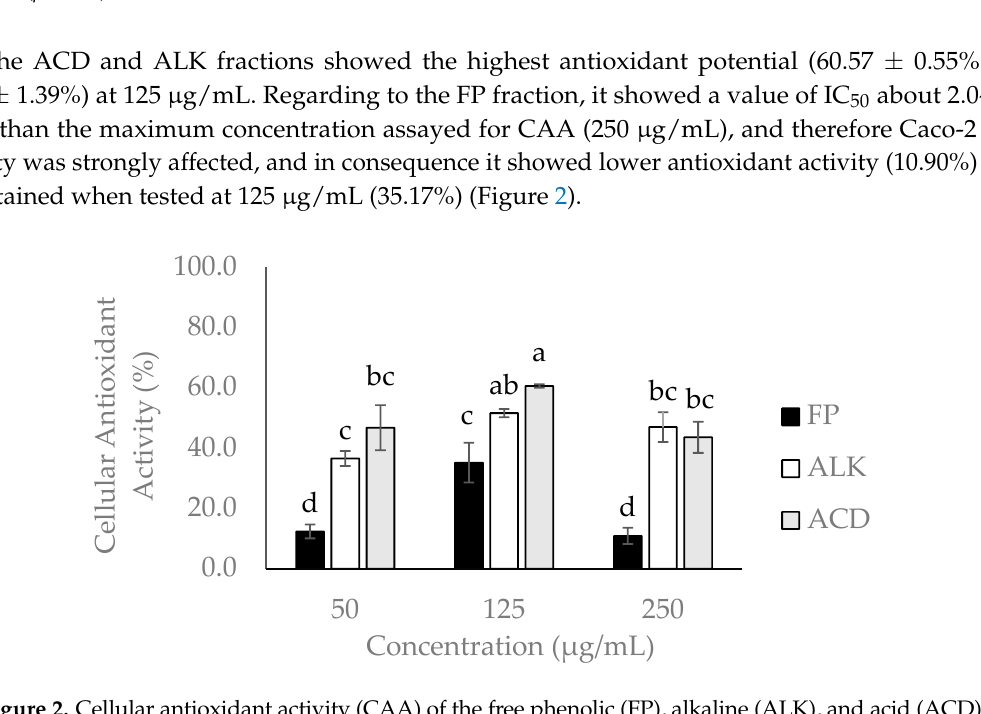
A, B, C Capital letters indicate difference between the extracts. a, b, c Small letters indicate differences between cell lines ( p < 0.05).